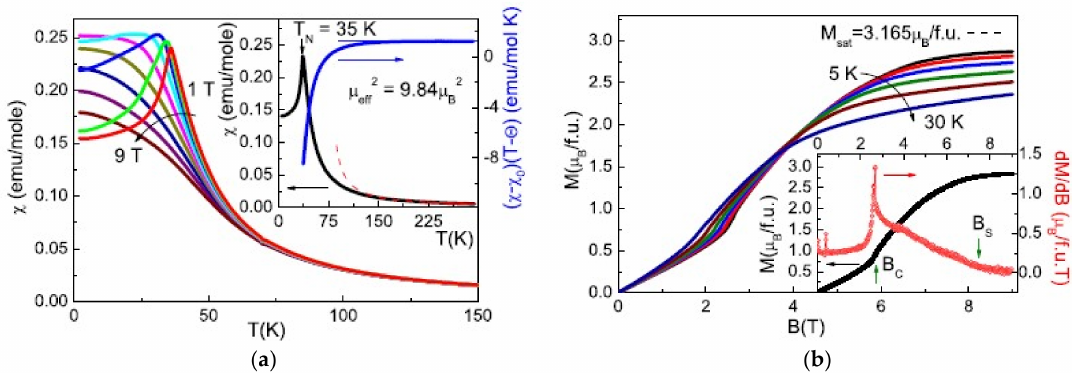
Figure 17. ( a ) The temperature dependence of the magnetic susceptibility of Cu 3 Y(SeO 3 ) 2 O 2 Cl at applied field strengths of 1–9 T, with a field step of 1 T. The inset represents the temperature dependence of the magnetic susceptibility at 0.1 T along with the Curie constant as a function of temperature. The dotted line represents an extrapolation of the Curie-Weiss type dependence from the high temperature region. ( b ) The field dependence of the magnetization in Cu 3 Y(SeO 3 ) 2 O 2 Cl over the temperature range of 5–30 K in steps of 5 K. The inset shows the field dependence of the magnetization at 2 K and its field derivative. Reprinted figure with permission from [32] Copyright (2014) by the American Physical Society.